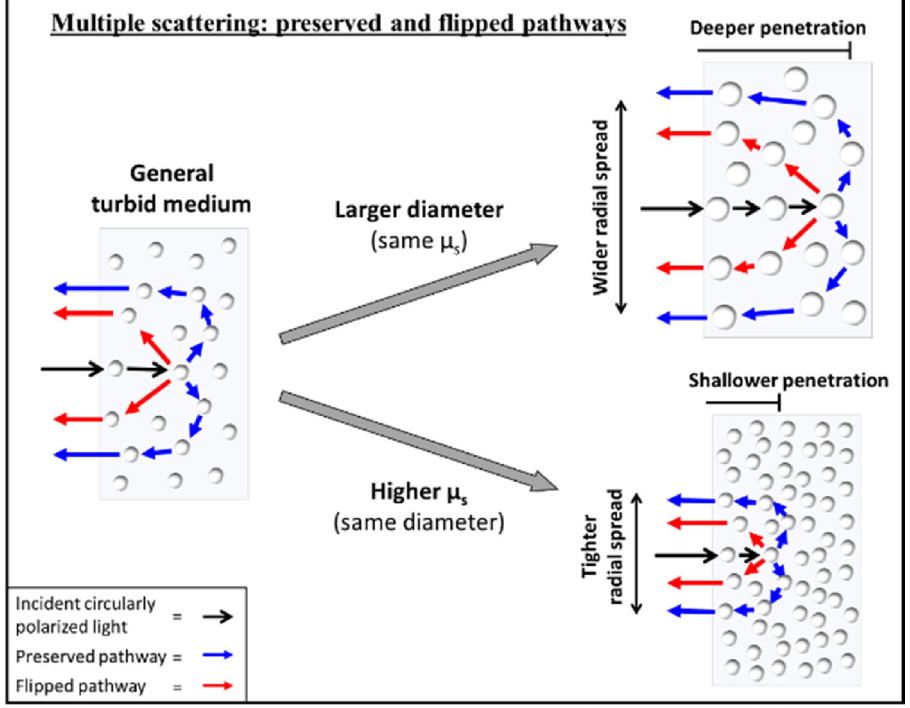
Figure 3. Schematic of flipped and preserved photons in multiple-scattering media, suggesting characteristic pathways distinguished by the presence (former) or absence (latter) of a large-angle backward-scattering event. As scatterer size increases (top right), one may expect deeper penetration and larger radial spread in the backward hemisphere. Higher turbidity (bottom right) is expected to confine light via the shorter mean-free path effect, resulting in shallower penetration and tighter radial spread. How these two properties influence the behaviour of both helicity-flipped and helicity-preserved subpopulations is discussed in the text.